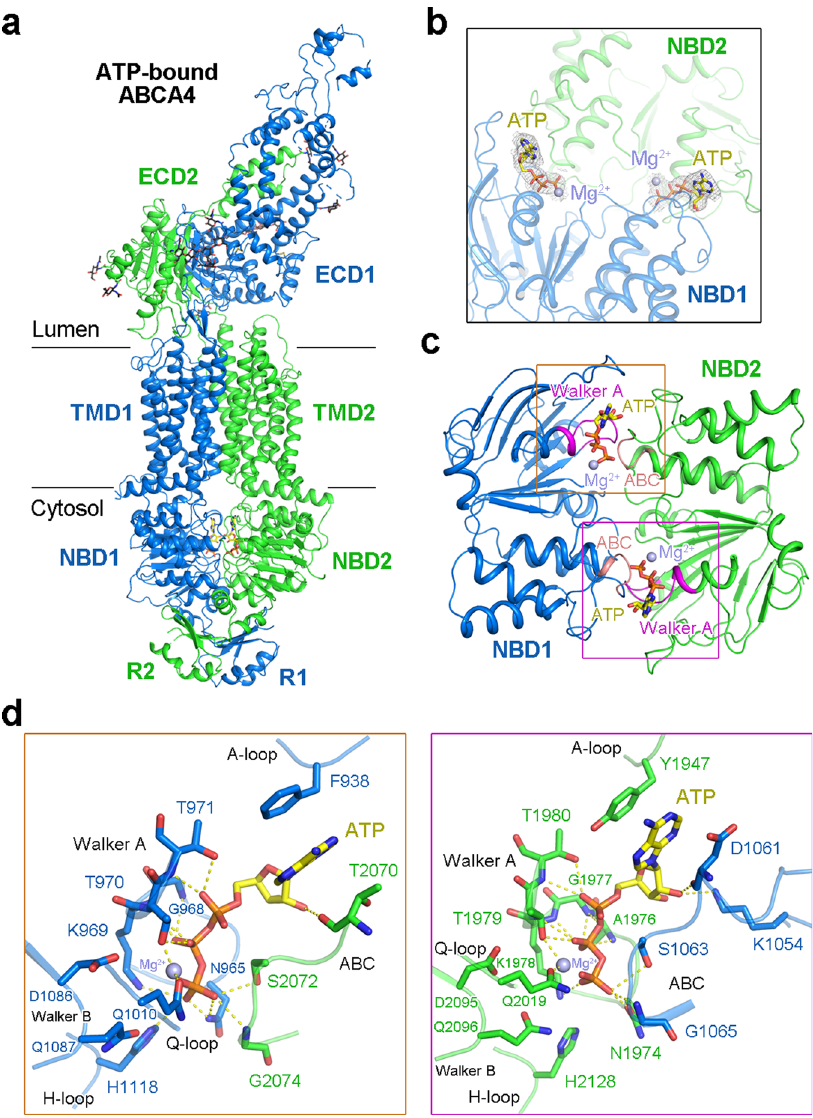
Fig. 4 Structure of ATP-bound ABCA4. a Overall structure of ATP-bound ABCA4. The domains are colored as above. b Electron density maps of ATP- Mg 2 + bound between the NBDs. The density maps, shown as gray mesh, are contoured at 5 σ . ATP molecules are shown as yellow sticks; Mg 2 + ions are displayed as purple spheres. c The NBD motifs involved in ATP-Mg 2 + coordination. The Walker A motifs and ABC signature sequences are highlighted in magenta and light pink, respectively. d Close-up views of the two ATP-binding sites. Key residues mediating the interactions are shown as sticks. Potential polar interactions are represented by yellow dashed